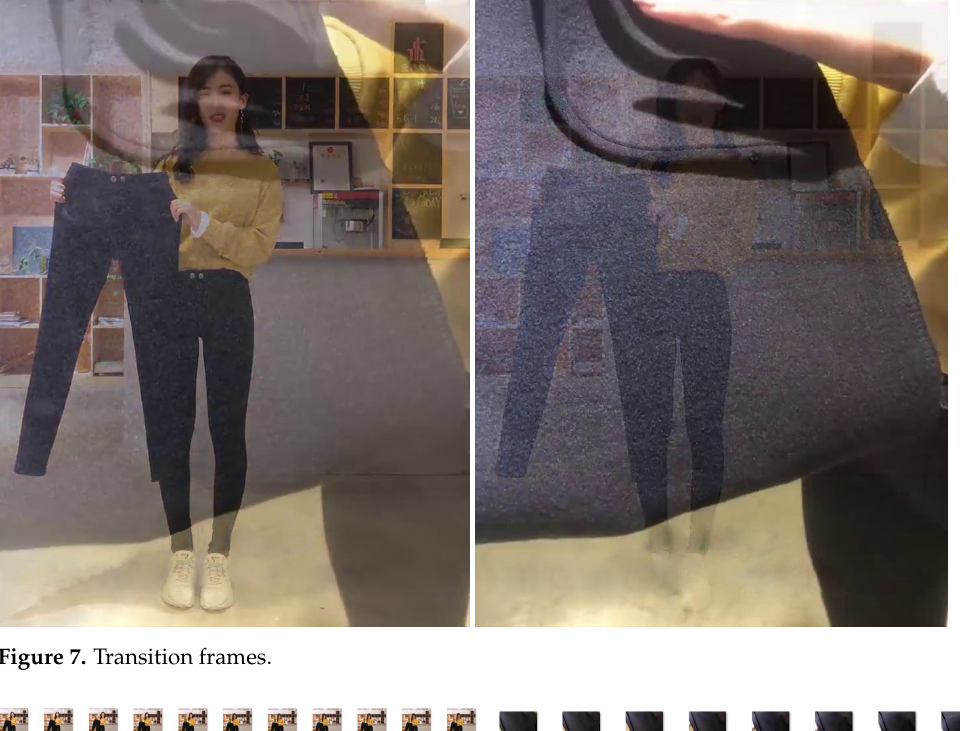
Figure 7. Transition frames.